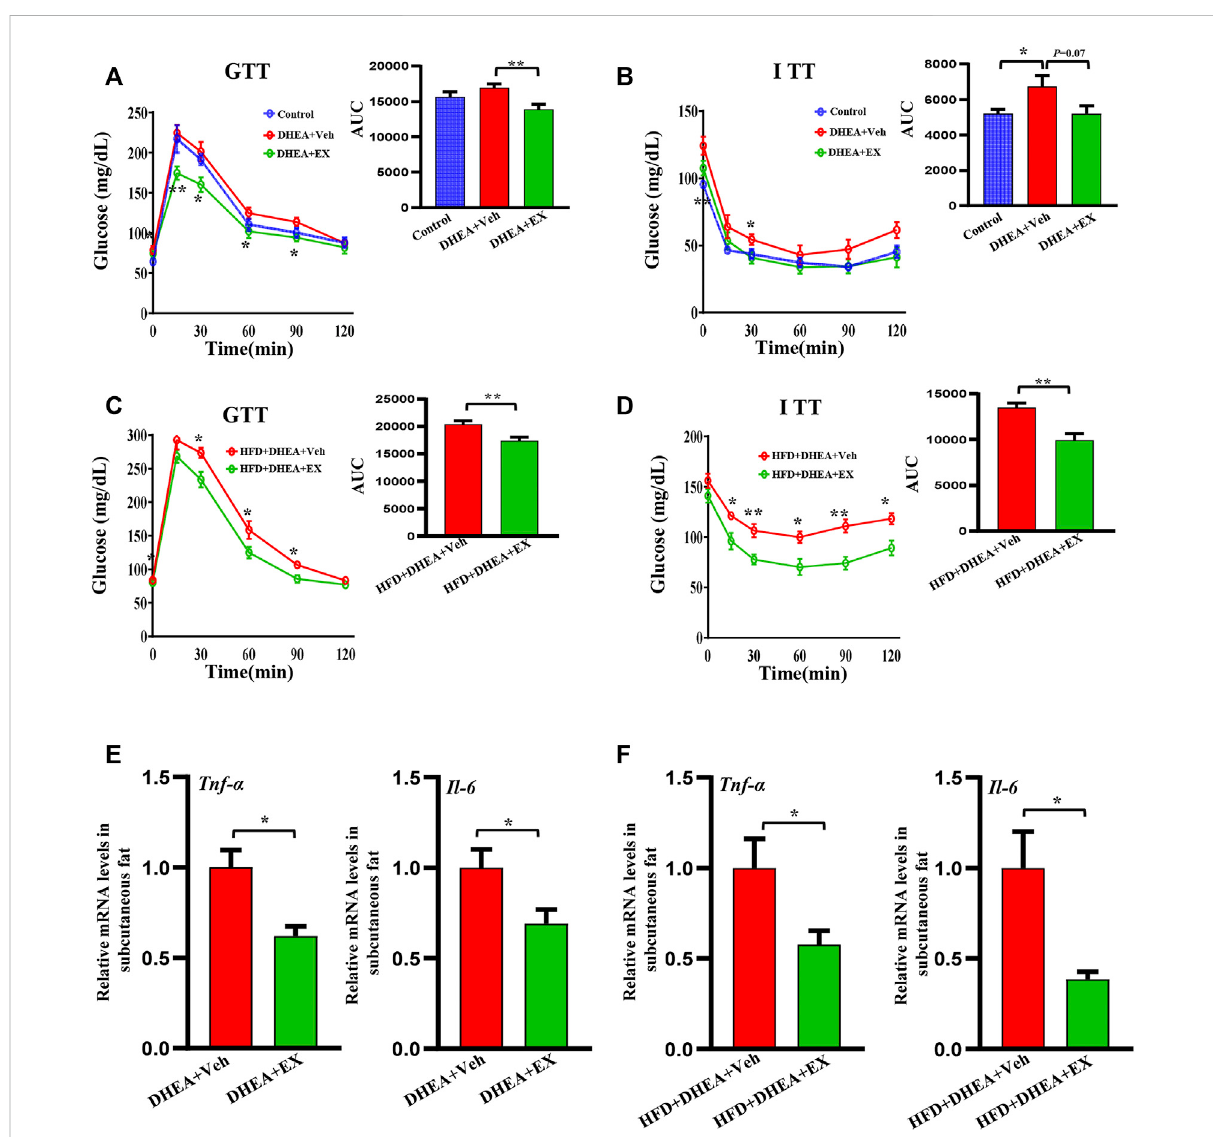
FIGURE 4 Enoxacin treatment ameliorated insulin resistance in PCOS. (A,B) GTT and ITT of mice upon chow diet conditions; (C,D) GTT and ITT of mice upon HFD conditions; (E) mRNA expression of in fl ammatory cytokines including Tnf- α , Il-6 in upon chow diet conditions; (F) mRNA expression of in fl ammatory cytokines including Tnf- α , Il-6 in upon HFD conditions. Values are represented as the mean ± SE. n = 5 – 6. For (A,B) , p values were determined by one-way ANOVA with Tukey ’ s multiple comparison post-hoc test. For (C – F) , p values were determined by two-tailed Student ’